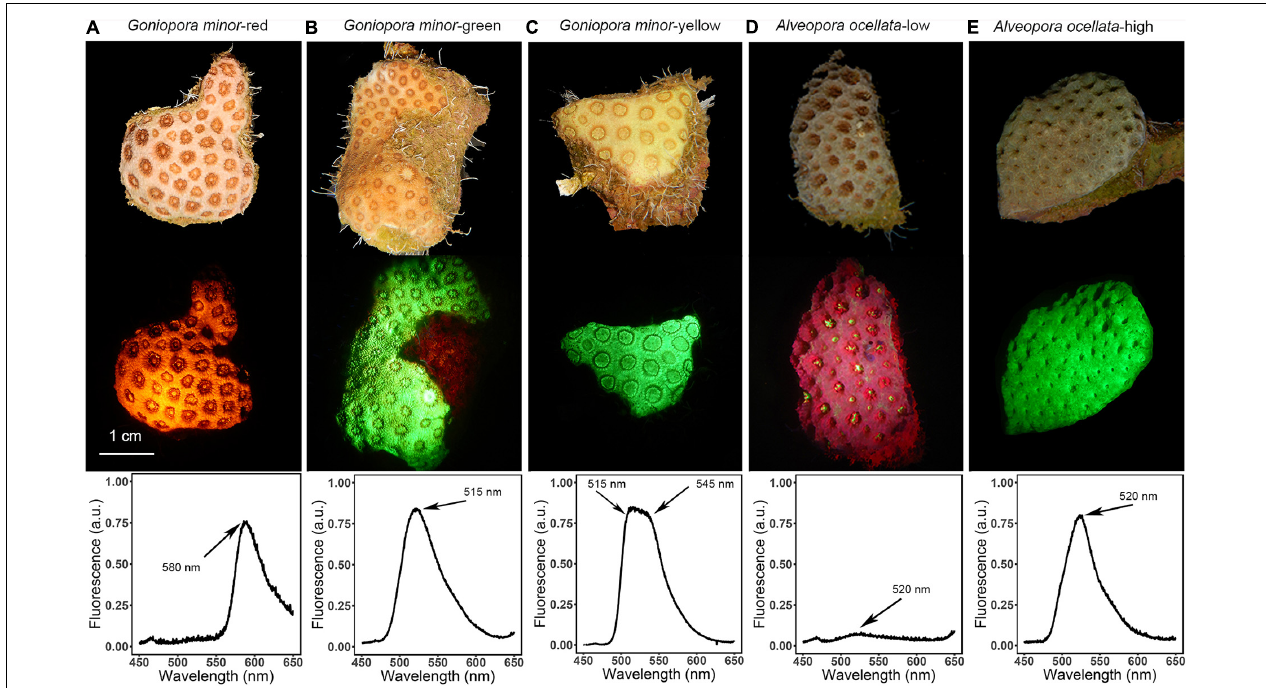
FIGURE 1 | Fluorescence diversity of mesophotic corals. Representative non-fluorescent images (top image in each panel); fluorescent images (middle image in each panel); and fluorescence emission spectra of Goniopora minor (A–C) and Alveopora ocellata (D,E) fluorescence morphs. Fluorescence emission peaks are indicated by